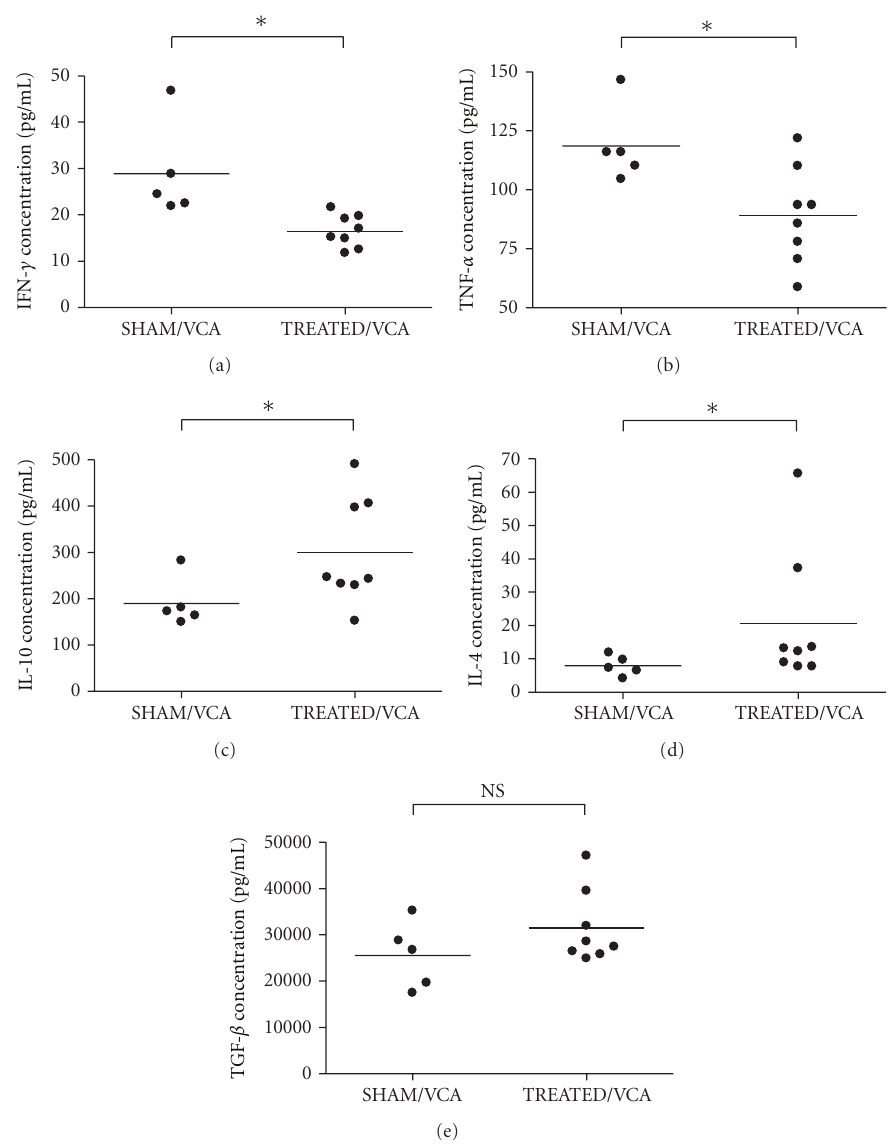
Figure 6: Cytokine concentrations according to flow-CBA ((a) IFN- γ ; (b) TNF- α ; (c) IL-10; (d) IL-4) and ELISA ((e) TGF- β ) in Day +7 sera from TREATED/VCA and SHAM/VCA Groups presented as scatter plots with mean bar. “ ∗ ” P < 0 . 05; “NS” P < 0 . 05 (specific P values provided in the